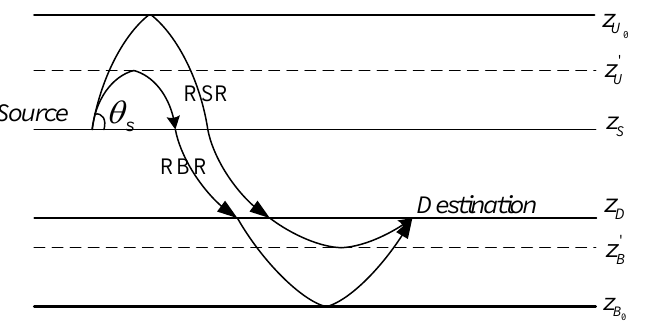
Figure 3. Refracted surface-reflection ray (RSR) and refracted bottom-reflection ray (RBR).